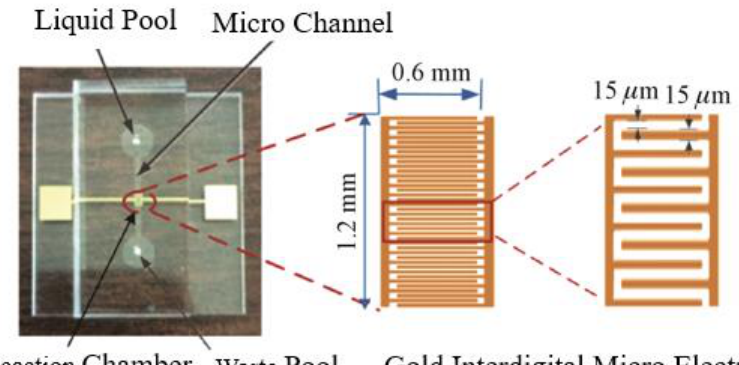
Figure 2. Schematic of gold interdigital microelectrodes.